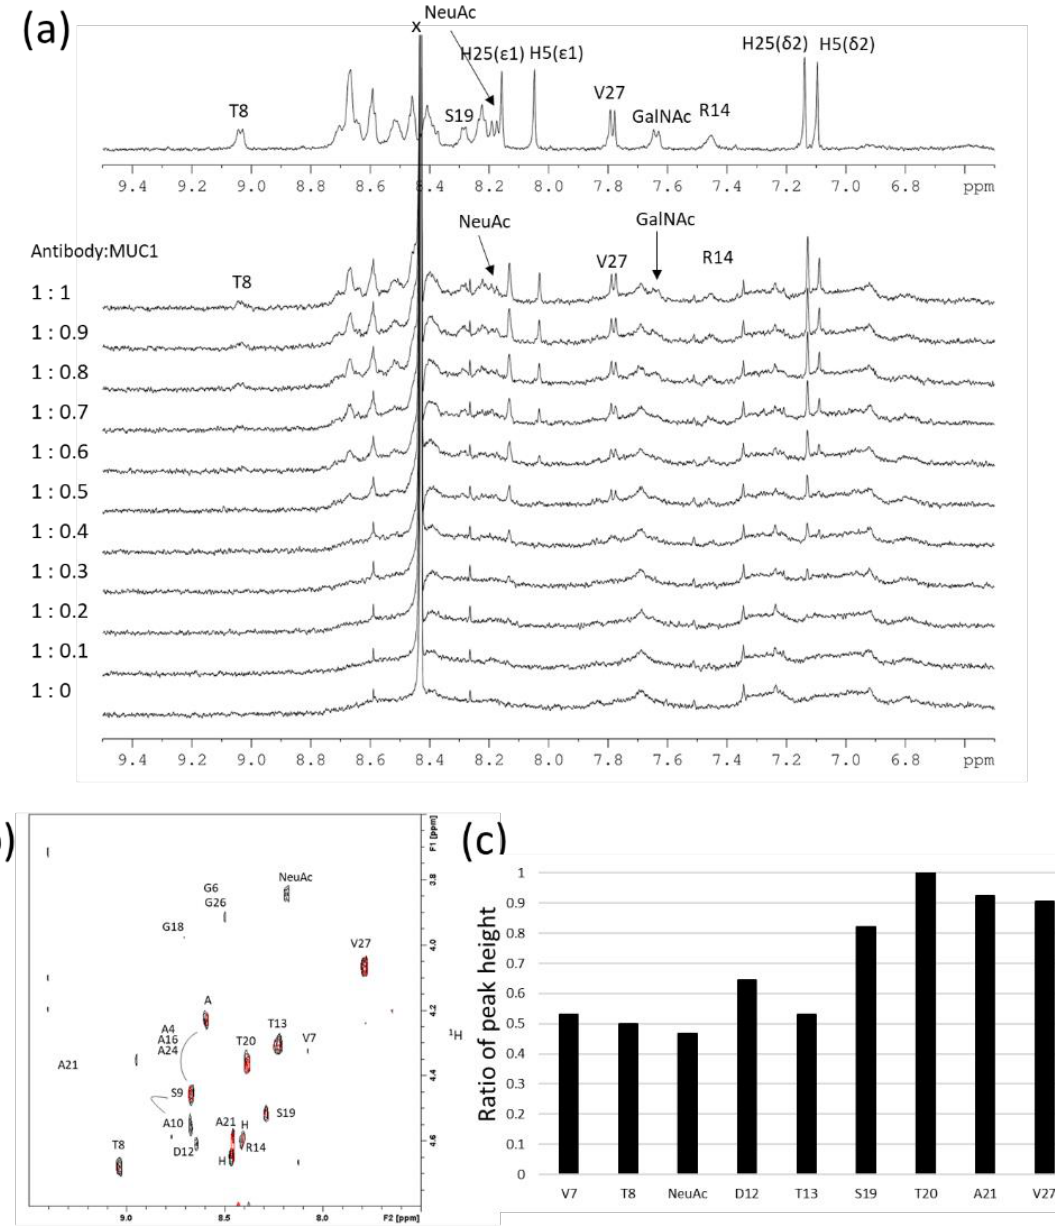
Figure 2. NMR titration experiments using MUC1 (27AA) and MY.1E12. ( a ) 1D- 1 H NMR spectra (amide NH region) of MY.1E12 with increasing amount of MUC1 (27AA). Molar ratios (binding site) are indicated for each spectrum. x: impurities. ( b ) 2D CLIP-COSY spectra (NH-H α region) of 25 µ M MUC1 (27AA) in the absence (black) or presence (red) of equimolar amount of MY.1E12. A4, A16, A24, S9 and A10 signals were not uniquely assigned. ( c ) Ratio of peak height (MUC1+antibody/MUC1 alone) for each NH-H α cross peak in CLIP-COSY spectra. The ratios are normalized against the highest value (T20). All experiments were performed on a 600 MHz spectrometer at 278 K.